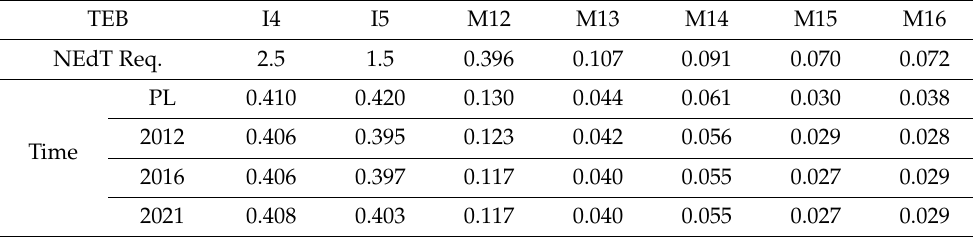
Figure 9. S-NPP VIIRS TEB band-averaged NEdT/Spec. during nominal operations (BB temperature at ~ 292.7 K) over the entire mission. Only HAM-side A is illustrated. Table 4. S-NPP VIIRS TEB band-averaged NEdT values at T typ . The NEdT values were extracted from the BB CD data. NEdT units are in Kelvin. PL stands for prelaunch.